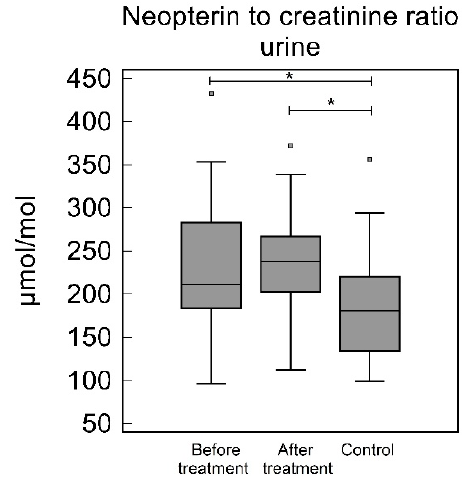
Figure 4. Neopterin to creatinine ratio in urine (NC). NC was significantly higher in study group, both before and after periodontal treatment to control group ( p = 0.02 and 0.0013, respectively). No significant difference was observed when before treatment NC were compared to after treatment NC ( p = 0.36) * p < 0.05.